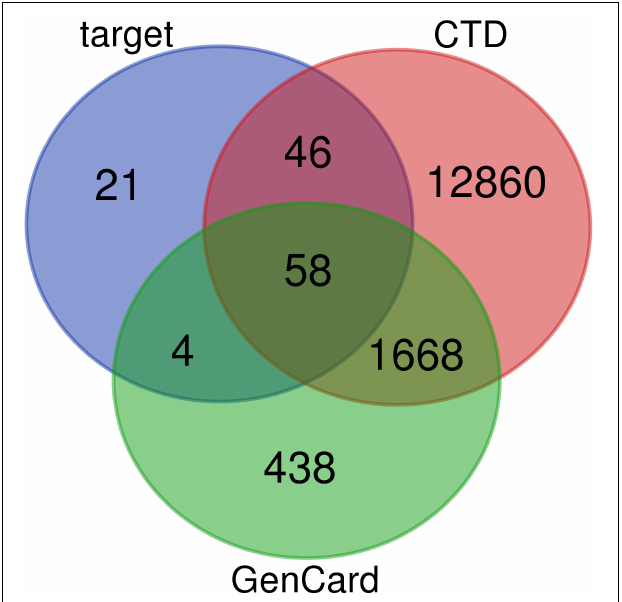
FIGURE 3 | Venn diagram of targets of EJSW and ITP (from Gene Cards database and CTD